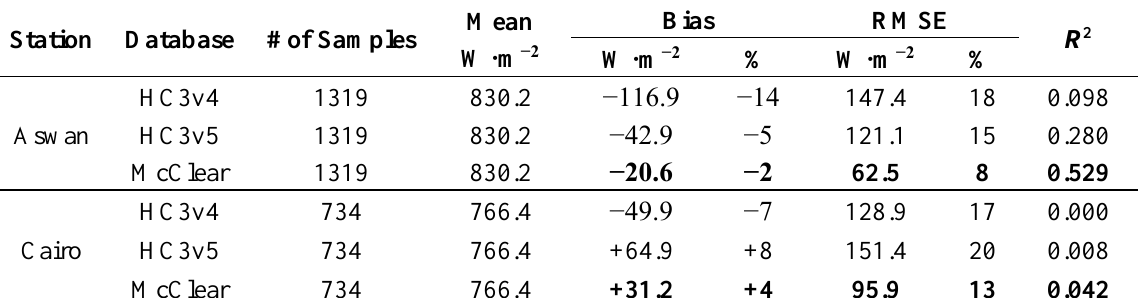
Table 4. Validation of the direct normal irradiance (DNI) under cloud-free conditions, the best values for each station are in